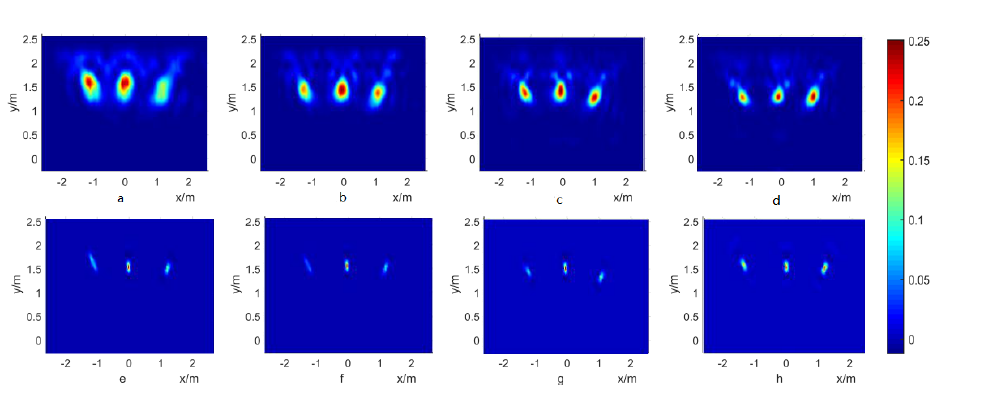
Figure 11. Blur image of the radiation antenna at frequencies of ( a ) 3 GHz; ( b ) 4 GHz; ( c ) 5 GHz; ( d ) 6 GHz; restoration result by log-polar transformation at ( e ) 3 GHz; ( f ) 4 GHz; ( g ) 5 GHz; and ( h ) 6 GHz frequency.